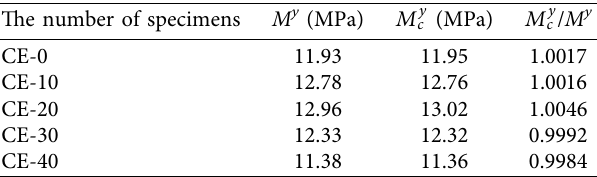
Table 6: Comparison of experimental and computational results according to formula (4).